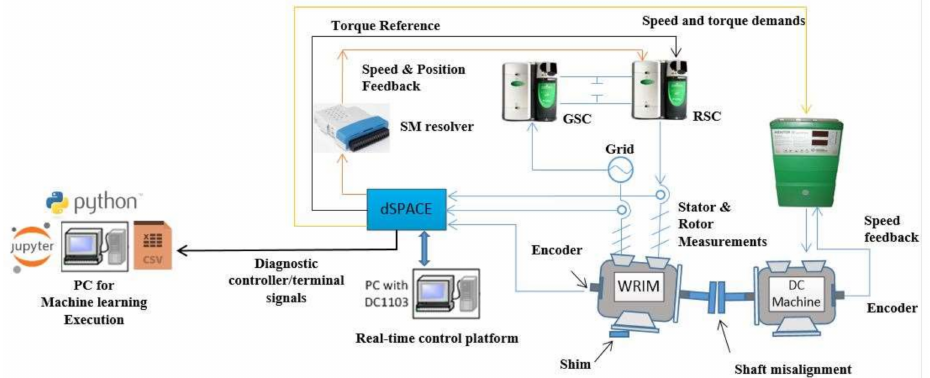
Figure 1. Simplified schematic diagram of the laboratory test rig.